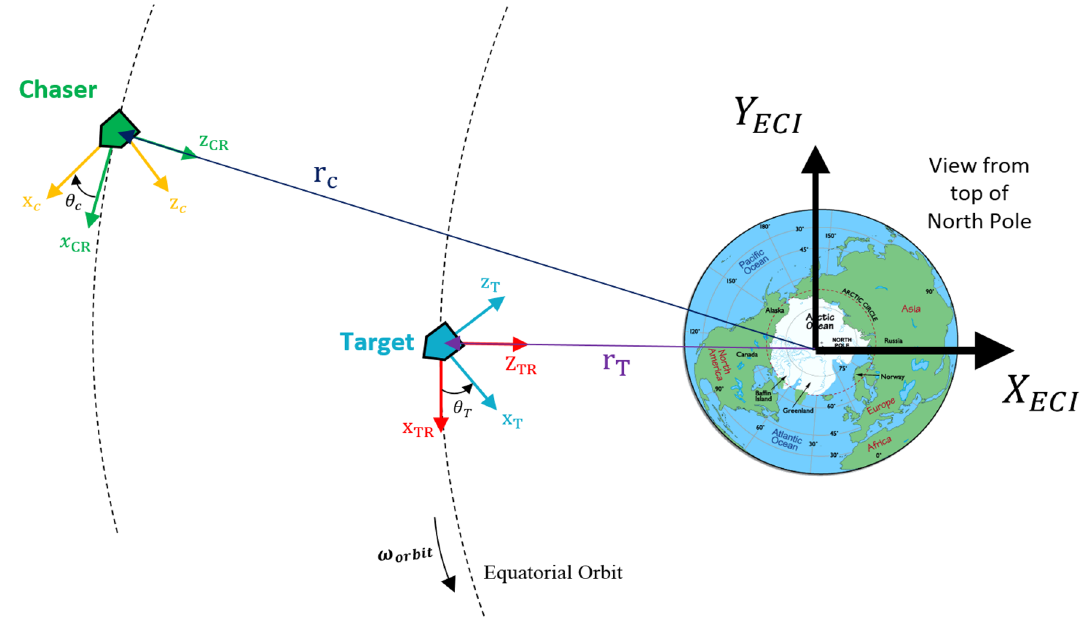
Figure 3. Schematic Definition of coordinate